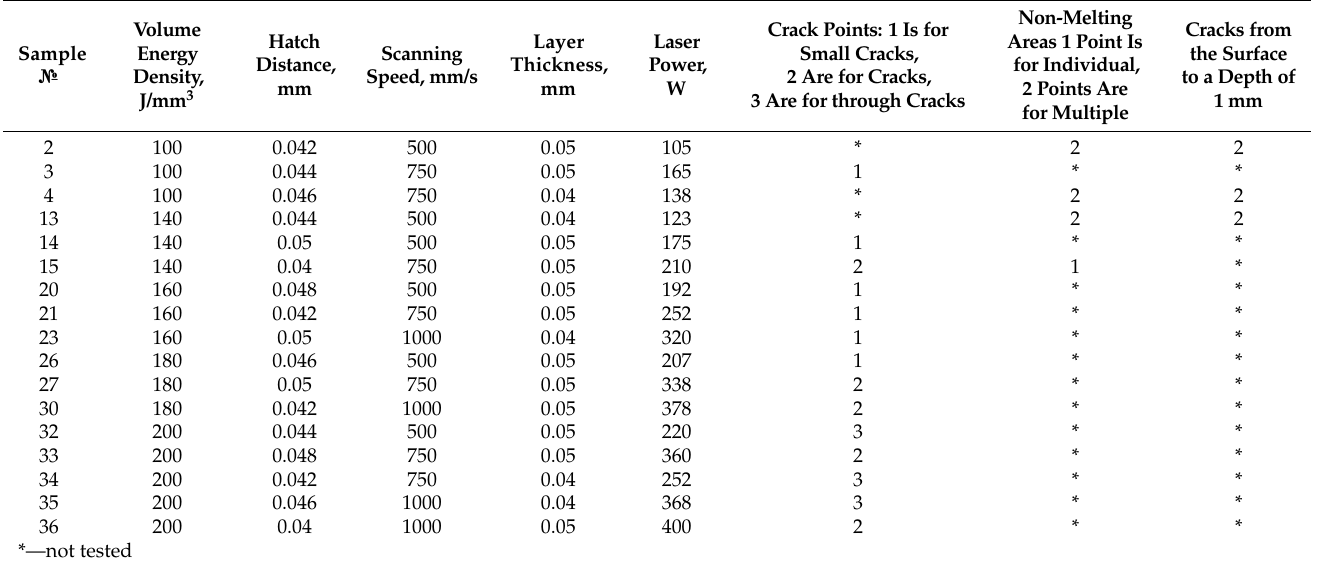
Table 2. The experimental plan.